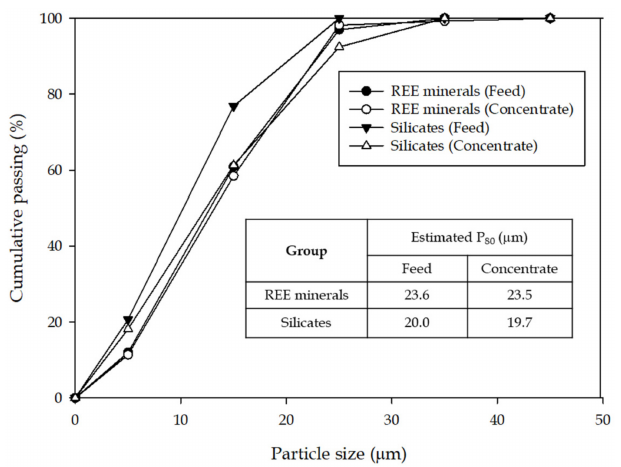
Figure 9. Grain size distribution of REE and silicate minerals in flotation feed and concentrate.